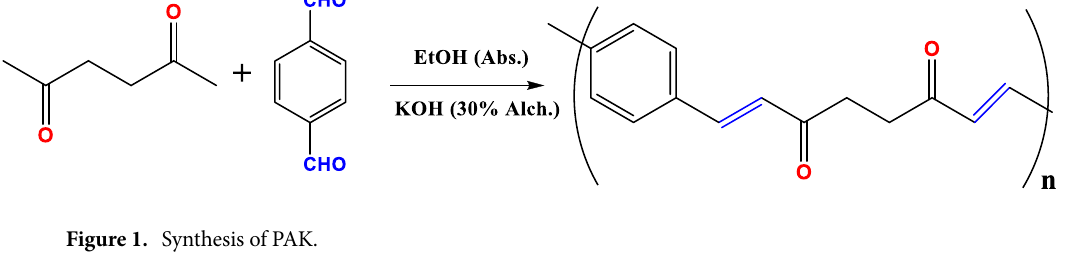
Figure 1. Synthesis of